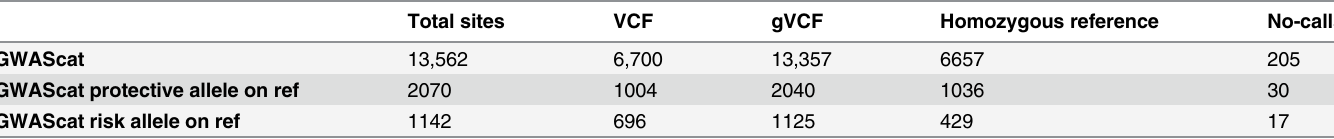
Table 2. Genotyping of GWAS catalog sites using the VCF and gVCF file formats and the number of homozygous reference sites and no-calls based on WGS